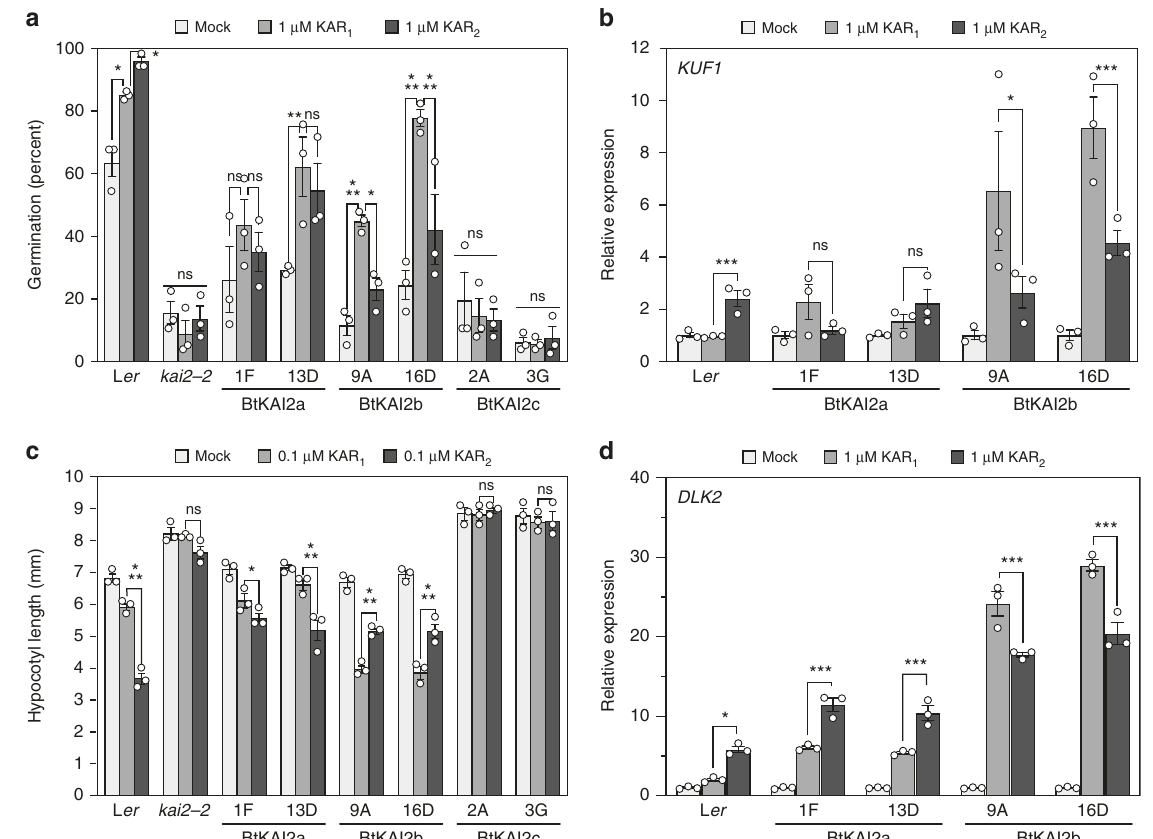
Fig. 3 Functional divergence between BtKAI2 homologues. a Germination responses of primary-dormant Arabidopsis seed homozygous for KAI2pro:GFP- BtKAI2 transgenes in the kai2-2 background. Germination values were determined 120 h after sowing. Extended germination curves are shown in Supplementary Fig. 7. Data are means ± SE, n = 3 independent seed batches, 75 seeds per batch. b Levels of KUF1 transcripts in KAI2pro:GFP-BtKAI2 seeds treated with 1 µ M KAR 1 or KAR 2 for 96 h (see Methods). Expression was normalised to CACS reference transcripts and scaled to the value for mock-treated seed within each genotype. Data are means ± SE of n = 3 biological replicates. c Hypocotyl elongation responses of KAI2pro:GFP-BtKAI2 seedlings treated with KAR 1 or KAR 2 . Data are means± SE of n = 3 biological replicates, 12 – 18 seedlings per replicate. d Levels of DLK2 transcripts in 8-day-old KAI2pro:GFP- BtKAI2 seedlings treated with KAR CACS reference transcripts and scaled to the value for mock-treated 1 or KAR 2 for 8 h. Expression was normalised to seedlings within each genotype. Data are means ± SE of n = 3 biological replicates. Pairwise signi fi cant differences: * P < 0.05, ** P < 0.01, *** P < 0.001; ns, P >0.05 (ANOVA). Source data are provided as a Source Data fi